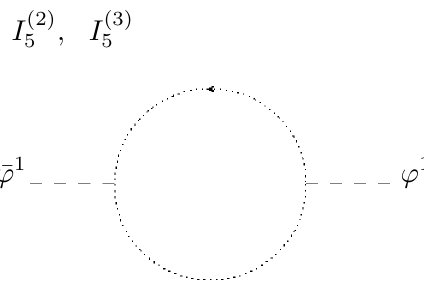
Figure 3 . Ghost loop correction I (2 , 3)